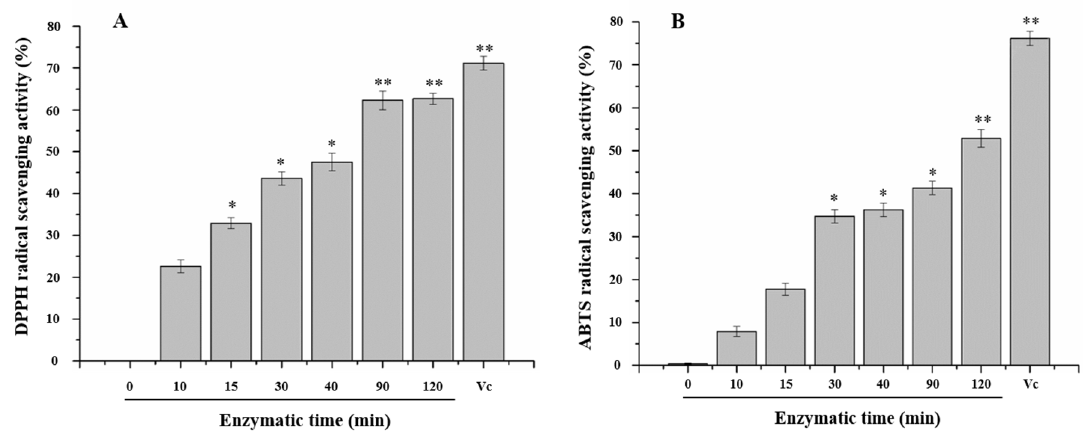
Figure 3. Scavenging ability of 2,2-diphenyl-1-picrylhydrazyl (DPPH) ( A ) and 8-aminonaphthalene- 1,3,6-trisulfonic acid (ANTS) ( B ) radicals of the digested sample. A concentration of 200 mg/L of ascorbic acid (Vc) was used as the positive control. * Shows statistically significant differences from value at 0 h, p < 0.05; ** Shows extremely significant differences from value at 0 h, p < 0.01 ( n = 3).